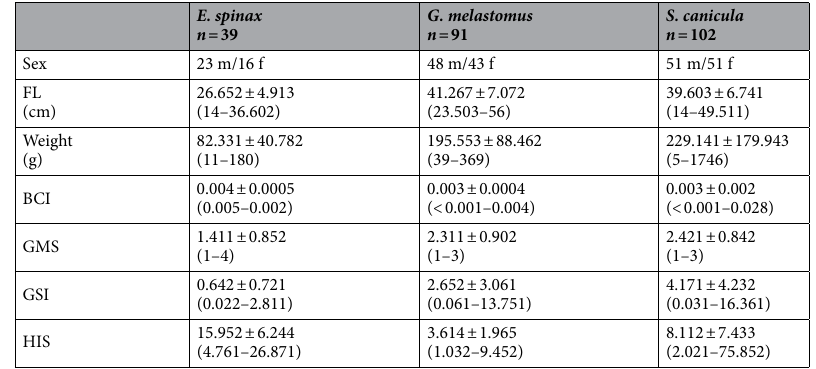
Table 1. Average values (± standard deviation and range in brackets) of morphological and physiological variables of E. spinax , G. melastomus , and S. canicula examined for parasites from the Gulf of Naples. Abbreviations: m, male; f, female; FL, fork length; BCI, body condition index; GMS, gonadal maturity score; GSI, gonadosomatic index; HIS, hepatosomatic